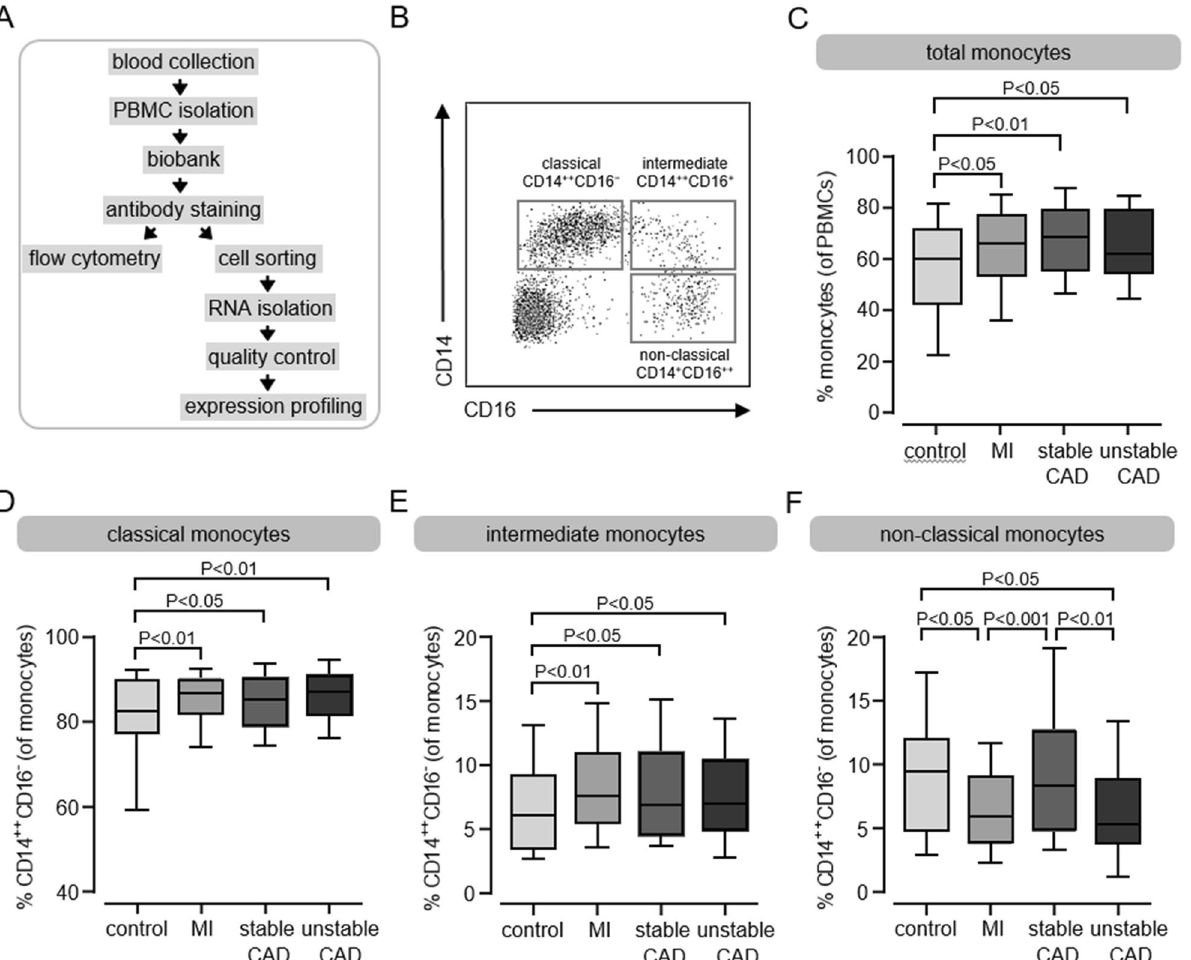
Figure 1. Analysis of monocyte subpopulations in patients with different stages of MI and CAD. ( A ) Flow chart of the experimental setup. ( B ) Sorting gates for the identification of human circulating blood monocyte subpopulations based on their relative CD14 and CD16 expression by flow cytometry and cell sorting. ( C ) Quantification of total monocytes, classical monocytes ( D ), intermediate monocytes ( E ) and nonclassical monocytes ( F ) in control subjects (n = 61) and in patients with MI (n = 110), stable CAD (n = 69) and unstable CAD (n = 65) by flow cytometry. Box plots with median and 25th/75th percentiles (boxes) and 10th/90th percentiles